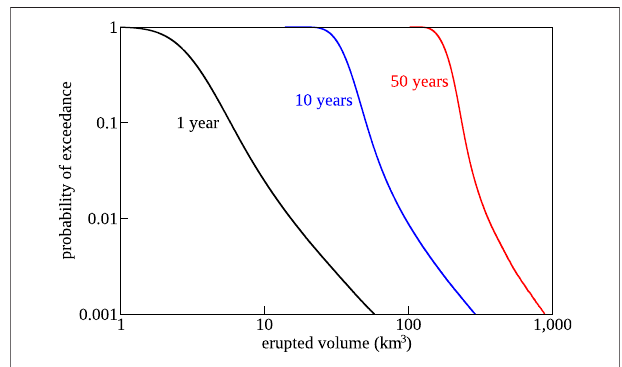
FIGURE 7 | Model forecasts in terms of probability of exceedance for any given volume over time windows of 1, 10, and 50 years.